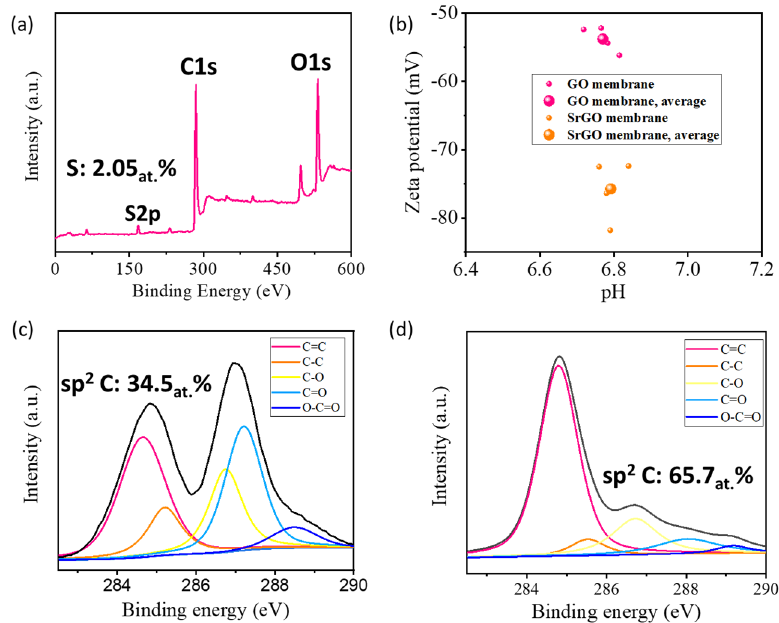
Figure 2. ( a ) XPS spectrum of a SrGO film; ( b ) Zeta potentials of a GO film and a SrGO film; ( c ) C1s spectrum of a GO film; ( d ) C1s spectrum of a SrGO film.